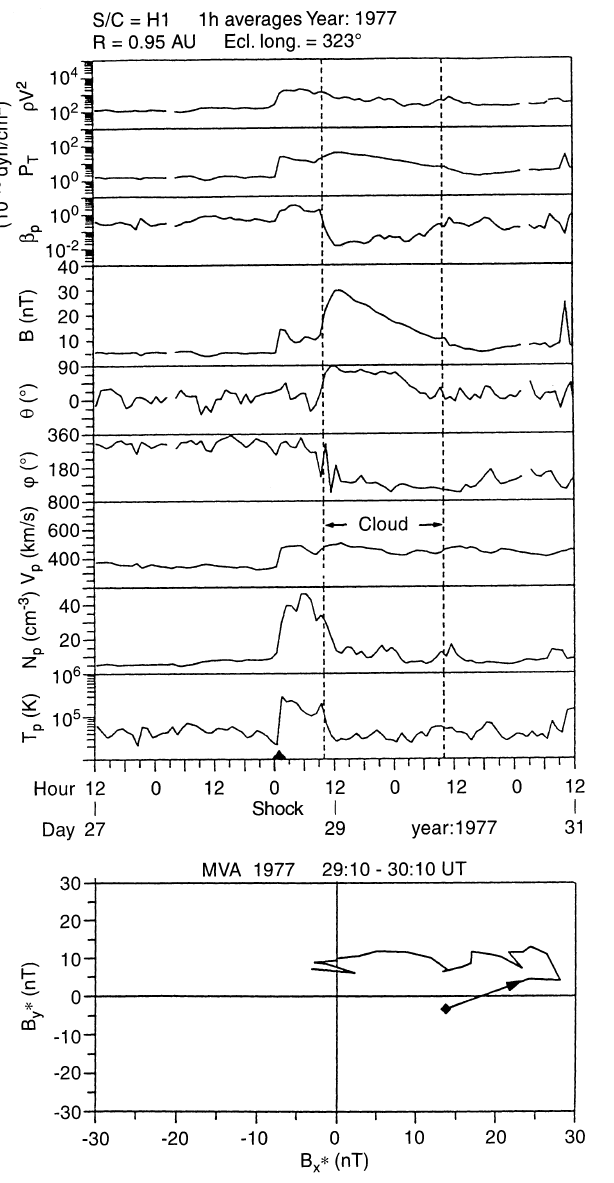
Fig. 7. A MC ( dashed lines ) of type NES observed with Helios 1 on days 29, 10 UT – 30, 10 UT in 1977. It was preceded by a shock on day 29, 01 UT. The bottom panel shows the counter-clockwise ‘‘rotation’’ with (cid:135) B y -values in the plane of maximum variance. The cloud’s axis was (cid:117) (cid:136) 103 (cid:14) , (cid:104) (cid:136) (cid:135) 8 (cid:14) , the minimum variance direction was (cid:117) (cid:136) 191 (cid:14) , (cid:104) (cid:136) (cid:255) 15 (cid:14)